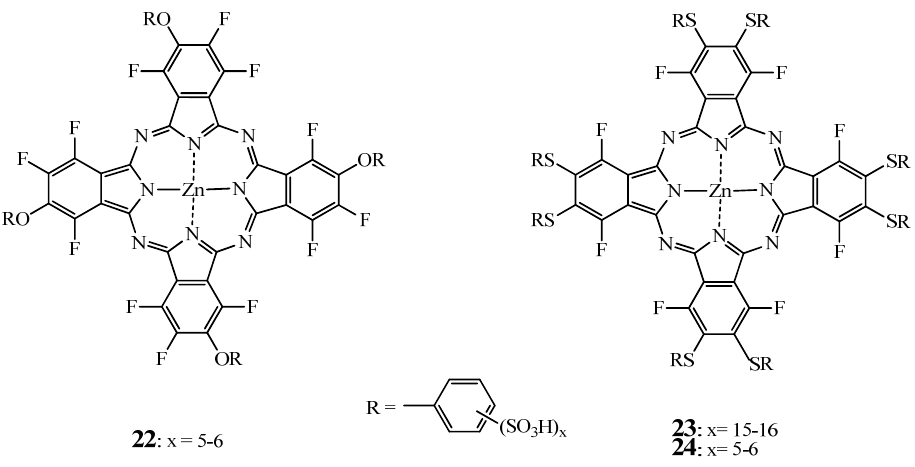
Figure 9. Structure of the fluorinated ZnPc 22 , 23 and 24 .